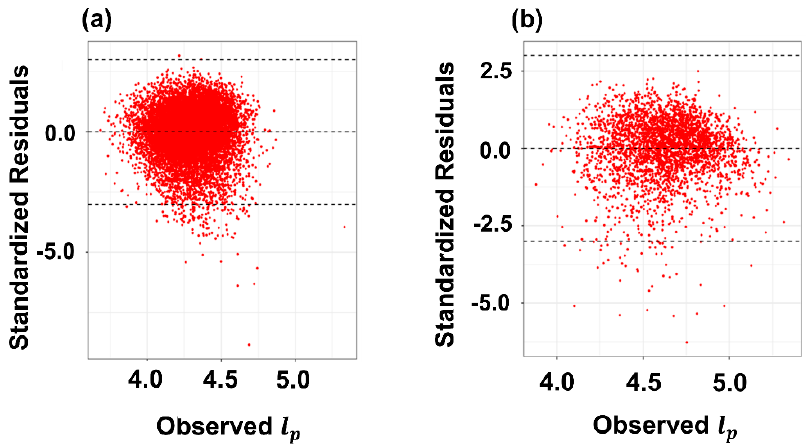
Figure 5. Standardized Residual Plots for ( a ) plant I and ( b ) plant II.